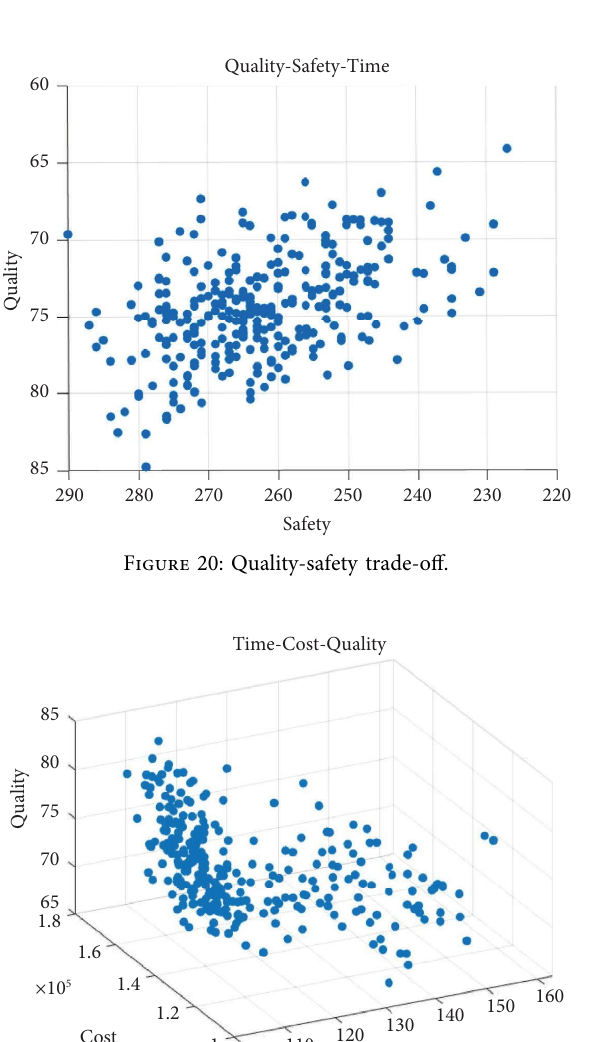
Figure 19: Cost-safety trade-of.